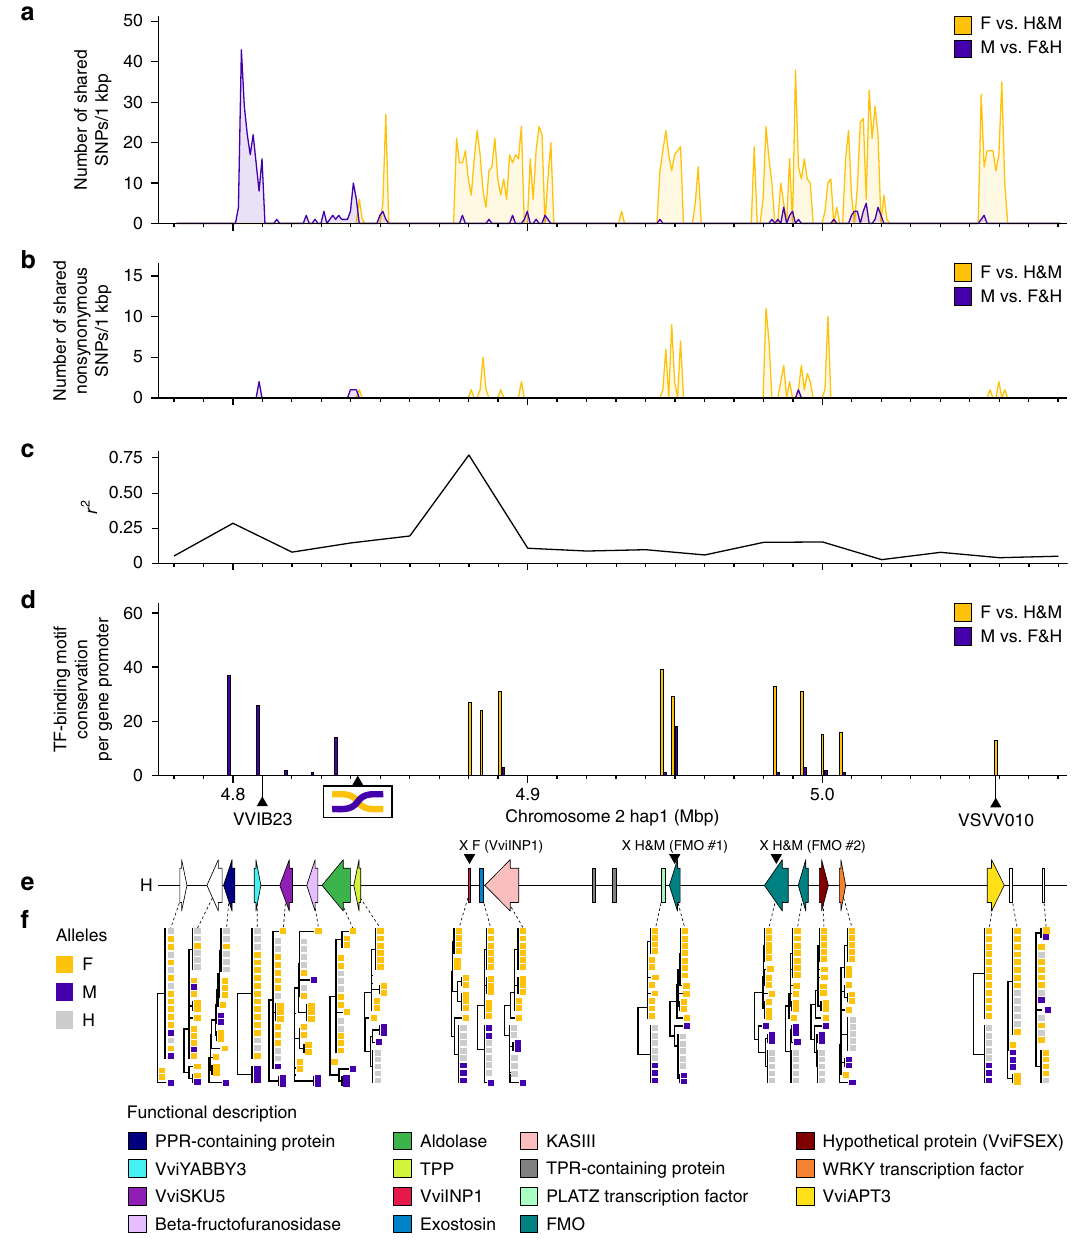
Fig. 3 Sex-linked polymorphisms along the sex-determining region in Vitis spp . The number of all ( a ) and nonsynonymous sex-linked SNPs ( b ) per kbp across the sex-determining region (SDR). SNPs were identi fi ed by aligning all Vitis haplotypes to Vv vinifera Cabernet Sauvignon hap1 (H). Only SNPs strictly (100%) linked to one sex type were plotted. c Linkage disequilibrium (LD) across the region represented as the median of the squared correlation coef fi cients ( r 2 ) between all pairs of SNPs calculated within 20 kbp windows. d TF-binding motif conservation per gene promoter detected in the SDR. The x -axis denotes the location on the Cabernet Sauvignon hap1 (H) SDR, and the two black triangles along this axis mark the position of the genetic markers VVIB23 17 and VSVV010 10 that are closely linked to the SDR. The potential position of the recombination event responsible for the reversion to hermaphroditism in domesticated Vv vinifera is also indicated. e Gene composition of the H haplotype of Vv vinifera Cabernet Sauvignon hap1. Genes are colored as in Fig. 2d and white-colored genes are not sex-linked. Genes affected by nonsense mutations are indicated with an X followed by the affected haplotype and the gene name in parentheses. f Neighbor-joining clustering of the protein sequences encoded by each gene of the SDR. Yellow, purple and gray colors represent F, M and H haplotypes, respectively. Source data underlying Figs. 3a – d, f are provided as a Source Data fi